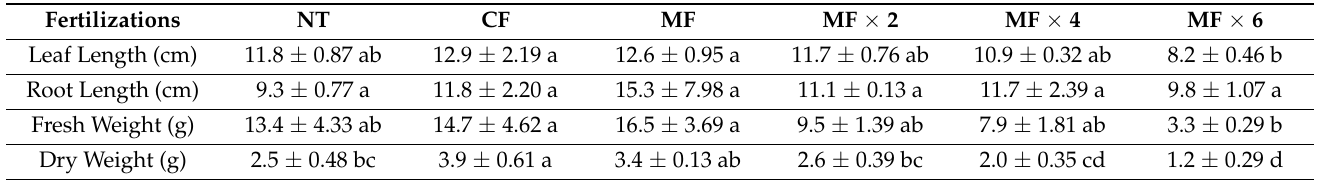
Table 2. Growth characteristics of Chinese cabbage.